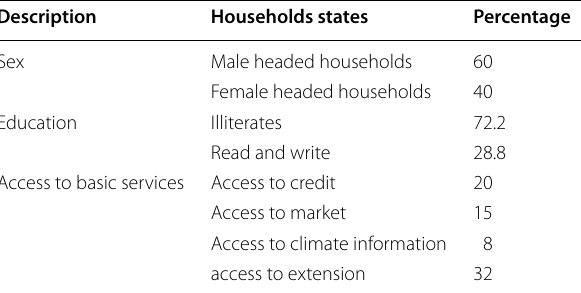
Table 3 Status of households regarding sex,